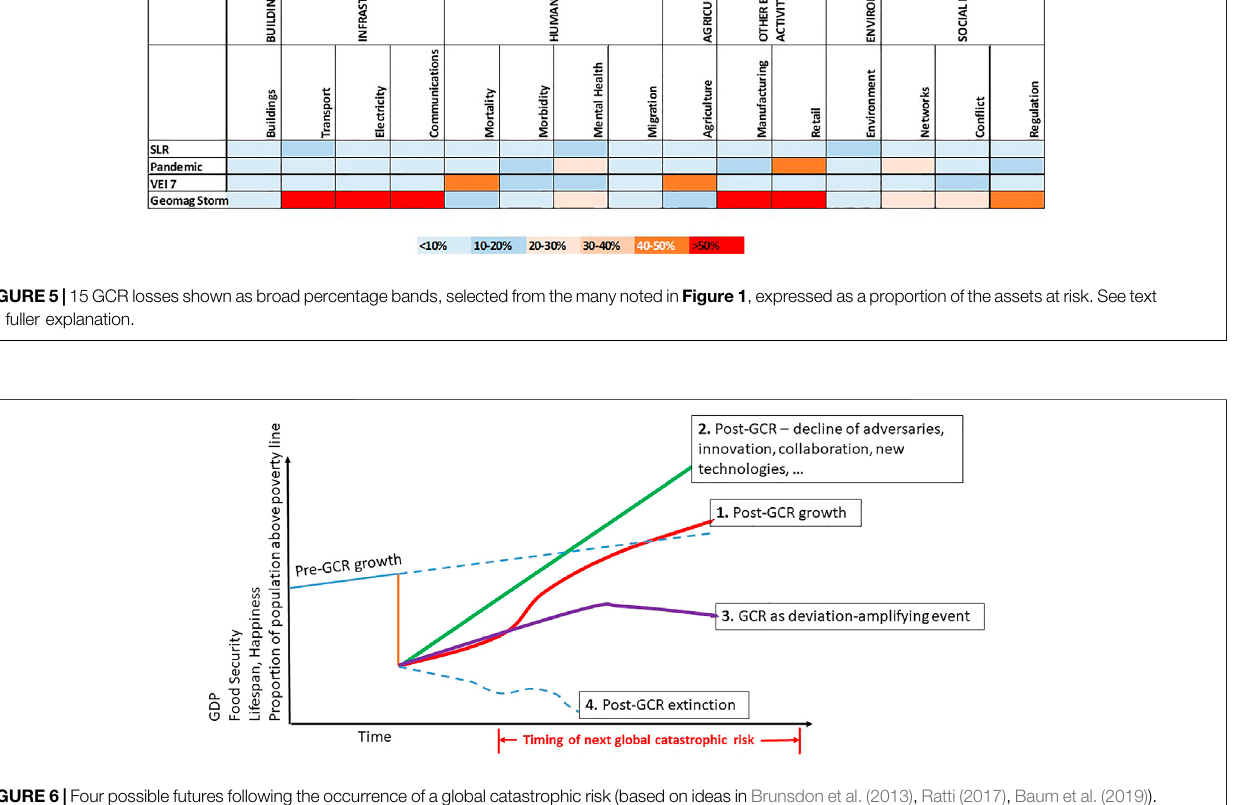
Frontiers in Earth Science |